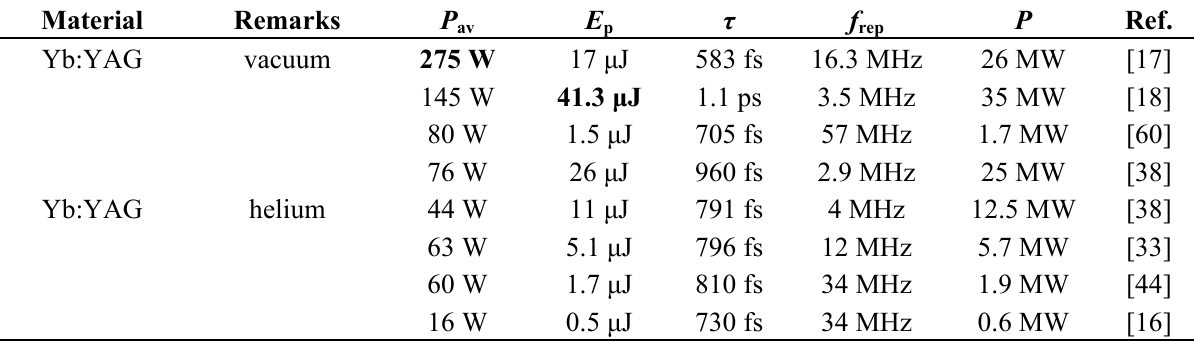
Table 5. Summary of results obtained with modelocked TDLs to date. Unless otherwise indicated, the oscillators were operated in